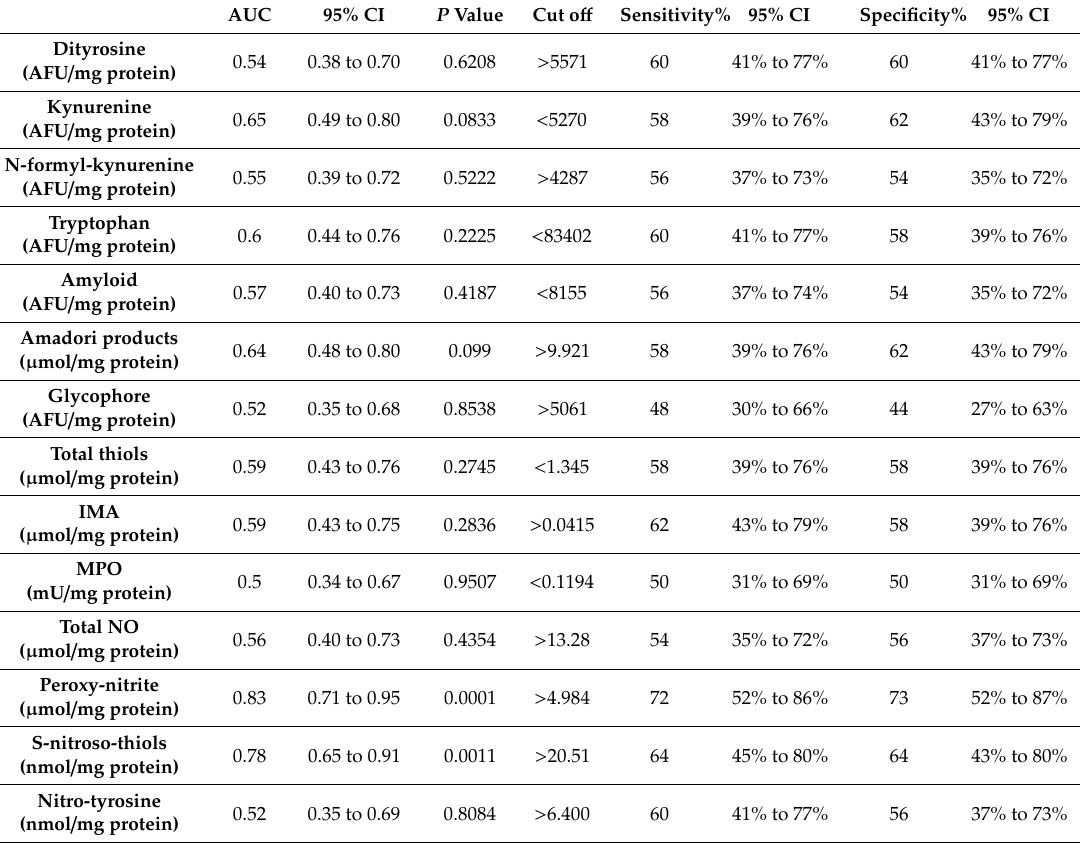
Table 3. Area under the curve (AUC) of protein glycoxidation and nitrosative stress biomarkers